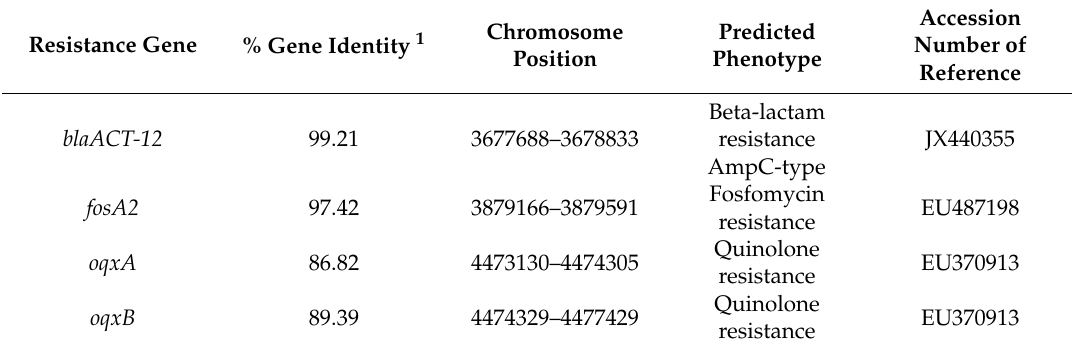
Table 2. List of antimicrobial resistance genes found in E. ludwigii CEB04.